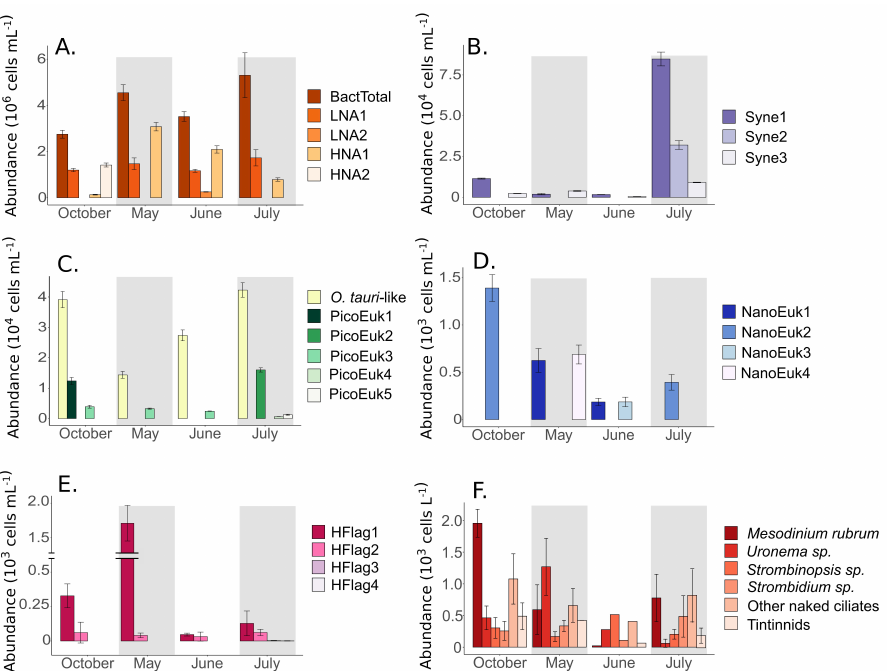
Figure 3. Abundances (cell mL − 1 ) of different bacterial (LNA1, LNA2, HNA1, and HNA2) ( A ), cyanobacterial (Syne1, 2, and 3) ( B ), and eukaryotic pico- and nanophytoplankton groups ( C , D ), heterotrophic flagellate (HFlag1, HFlag2, HFlag3, and HFlag4 ( E ), and different groups of ciliates ( F ) encompassing Mesodinium rubrum , Uronema sp., Strombidinopsis sp., Strombidium sp., and other naked (aloricate) ciliates and tintinnids in October, May, June, and July. White and gray columns help to distinguish different months in the figures.